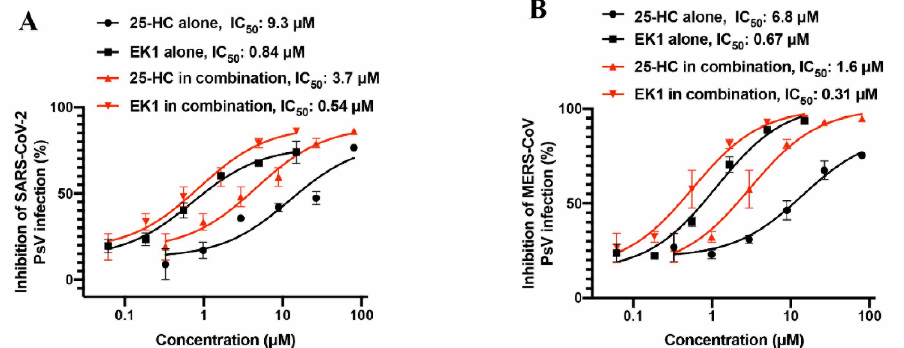
Figure 2. Combinations of 25-HC and EK1 show improved HCoV inhibitory activity. ( A ) Combinations of 25-HC and EK1 show improved HCoV inhibitory activity against SARS-CoV-2 PsV. ( B ) Combinations of 25-HC and EK1 show improved HCoV inhibitory activity against MERS-CoV PsV. The effective concentrations of EK1 or 25-HC tested alone or in combination for inhibiting SARS-CoV-2 or MERS-CoV pseudovirus infection are plotted with two curves. The black curves represent the inhibitory activity of EK1 or 25-HC tested alone, while the red curves represent the inhibitory activity of EK1 or 25-HC tested in EK1/25-HC combination. Each sample was tested in duplicate and experiments were repeated twice.